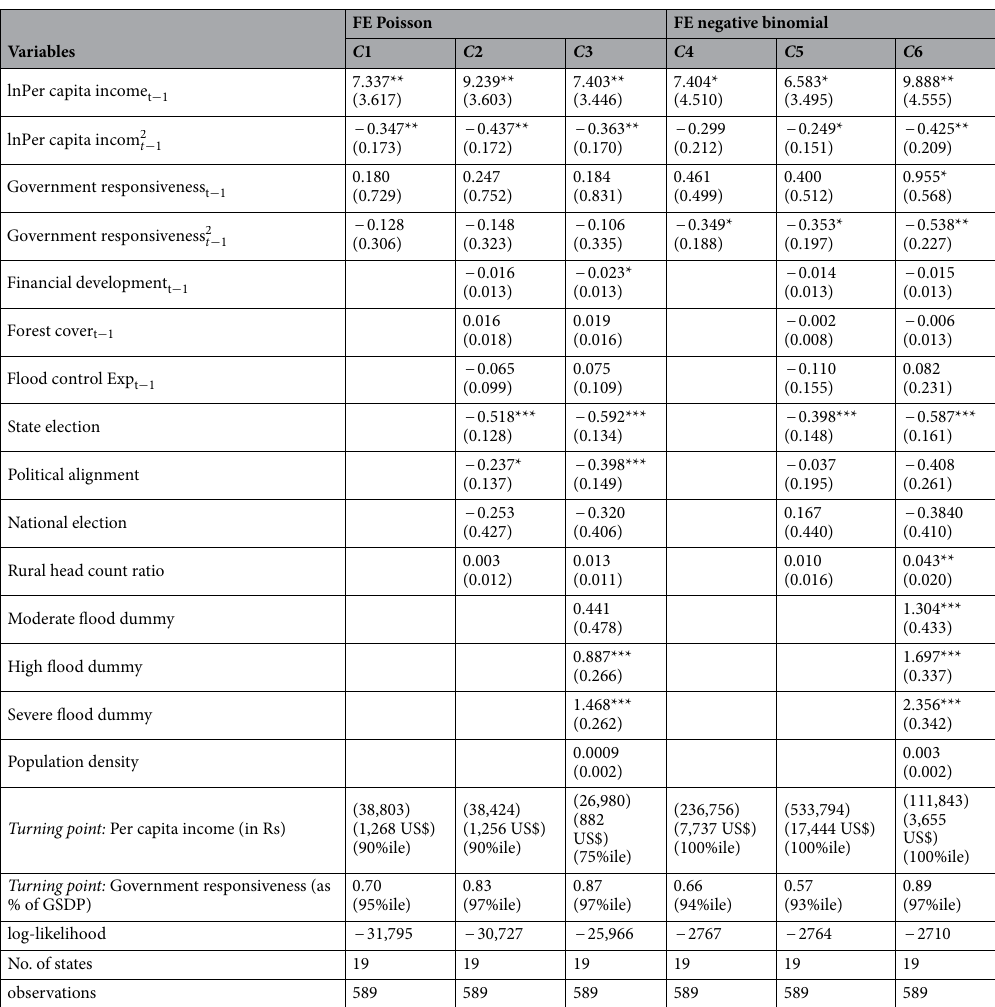
Table 1. Flood fatalities, per capita income (PCI) and Government responsiveness (All States). Clustered standard errors at state-level are reported in parentheses. The level of significance at *** p < 0.01, ** p < 0.05, * p < 0.1. The dependent variable is flood fatalities. Time-invariant state and year fixed effects are included in all models. The low flood is the baseline dummy